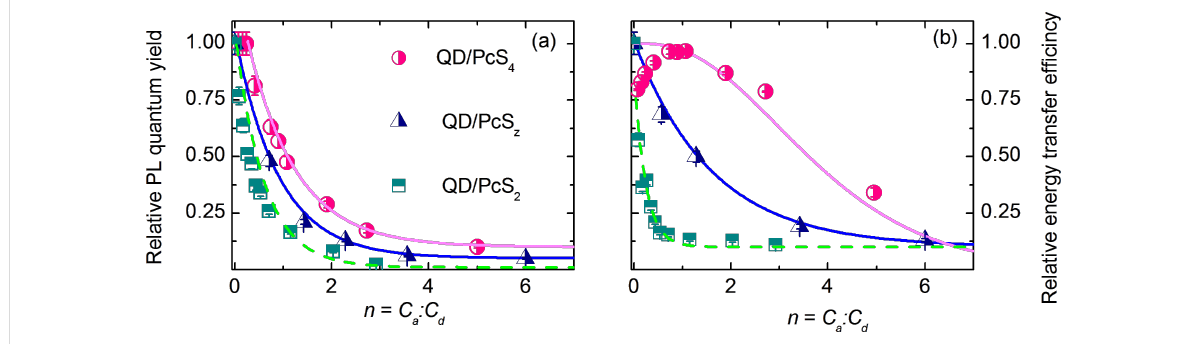
Figure 5: Dependencies of the relative QY of directly excited acceptor PL (a) and of the energy transfer efficiency (b) in complexes of QD and phthalocyanines with different numbers of sulfo groups on the relative phthalocyanines concentration n in the mixtures: PcS 4 (red circles), PcS 2 (green squares), original PcS z mixture (black triangles). Symbols in (a) and (b) are experimental data of QY of directly excited acceptor PL and energy transfer efficiencies, calculated using Equation 7 and Equation 8, respectively, and fitted with and E h curves (solid lines), calculated from the model (Equation 11 and Equation 12) with values of: α = 3 and = 3 for PcS 4 (red line); α = 1 and = 1.2 for PcS z (black line); α = 1 and = 3 for PcS 2 (green line). The blue line is to guide the